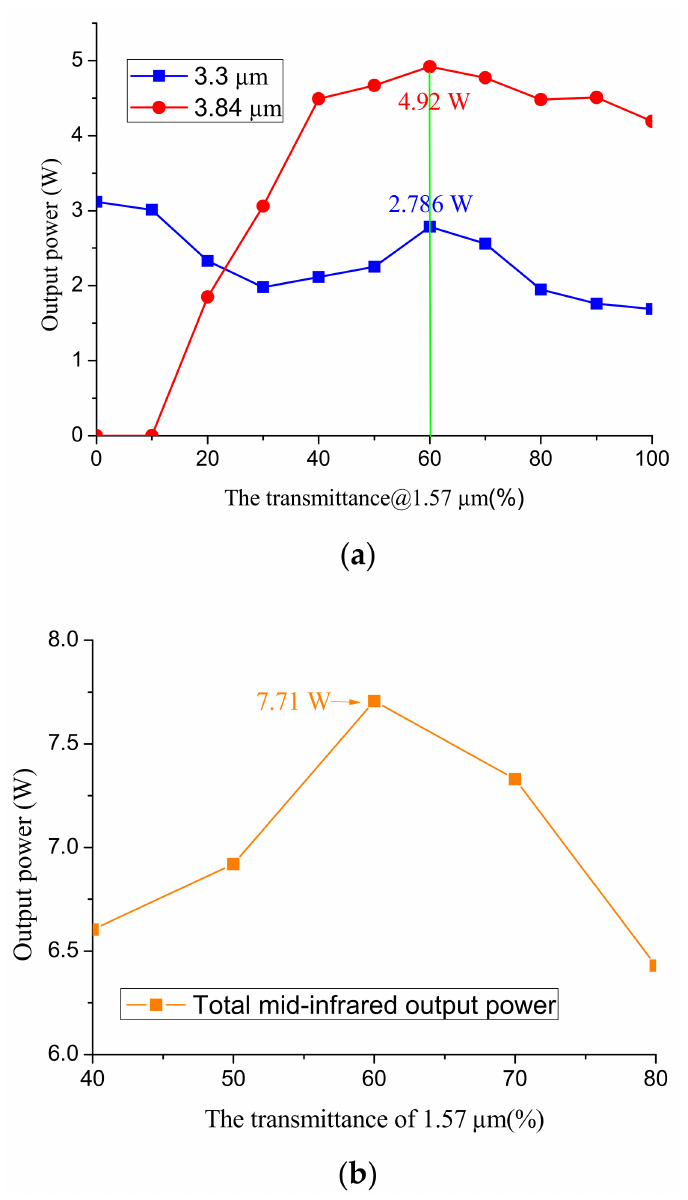
Figure 7. The output power of mid-infrared lasers under different transmittance. ( a ) The output power of mid-infrared lasers under different transmittance. ( b ) The total power of dual-wavelength under different